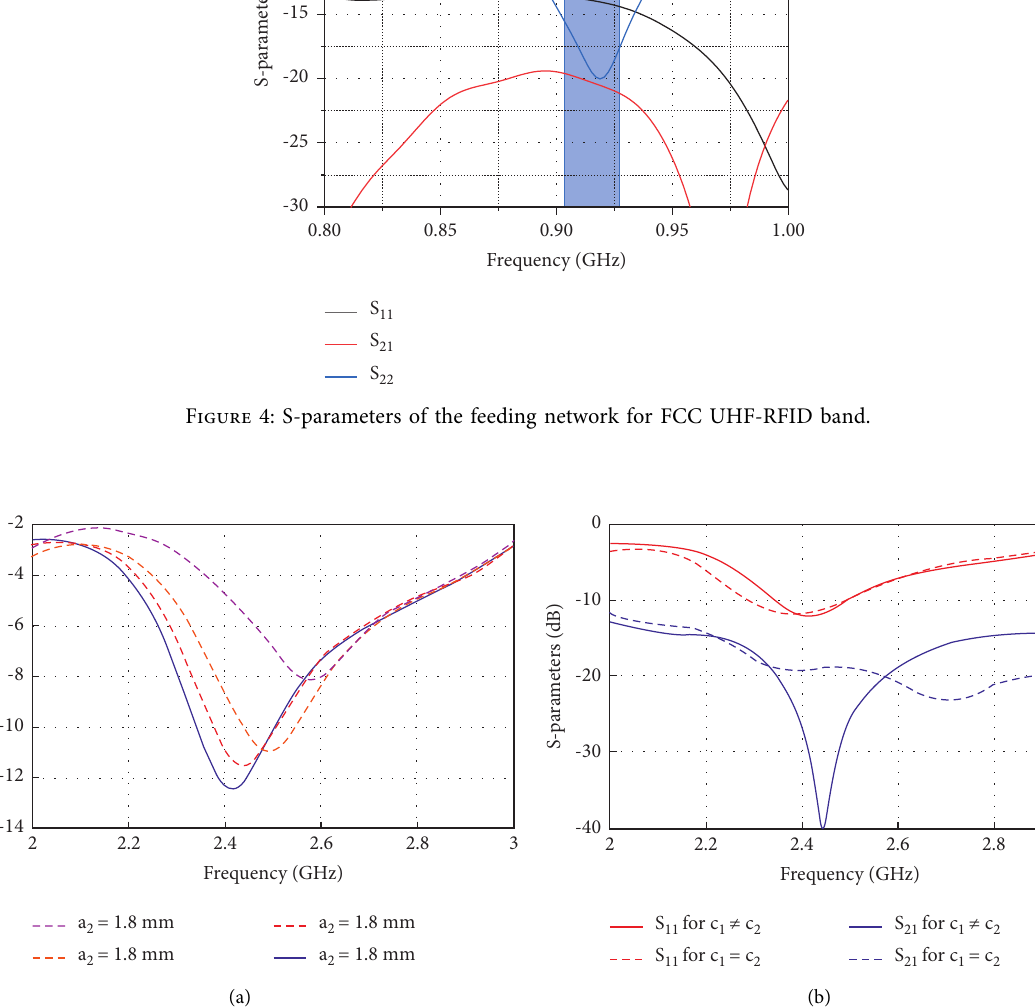
2 and (b) employing nonuniform-width